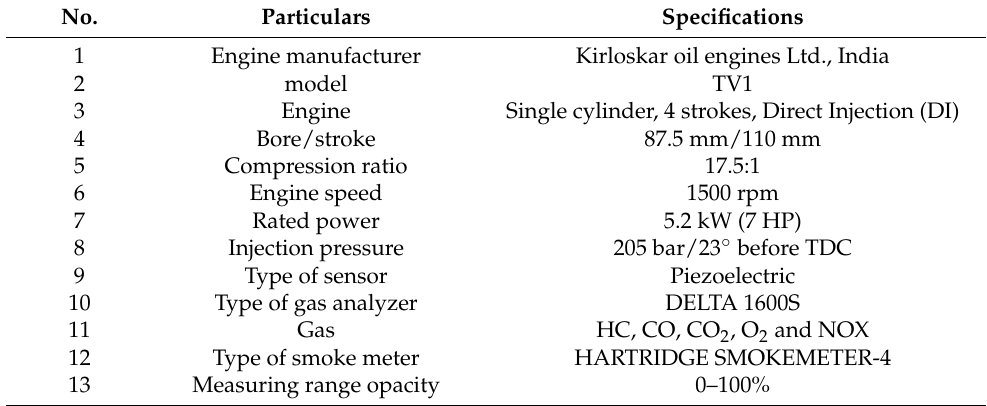
Table 4. Specification of the engine and emission meters Reproduced from [55], Elsevier: